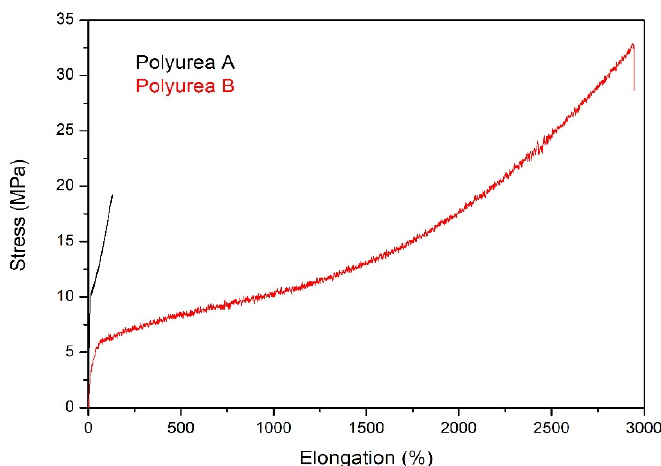
Figure 8. Comparison between the tensile properties of a specimen of polyureas A and B.